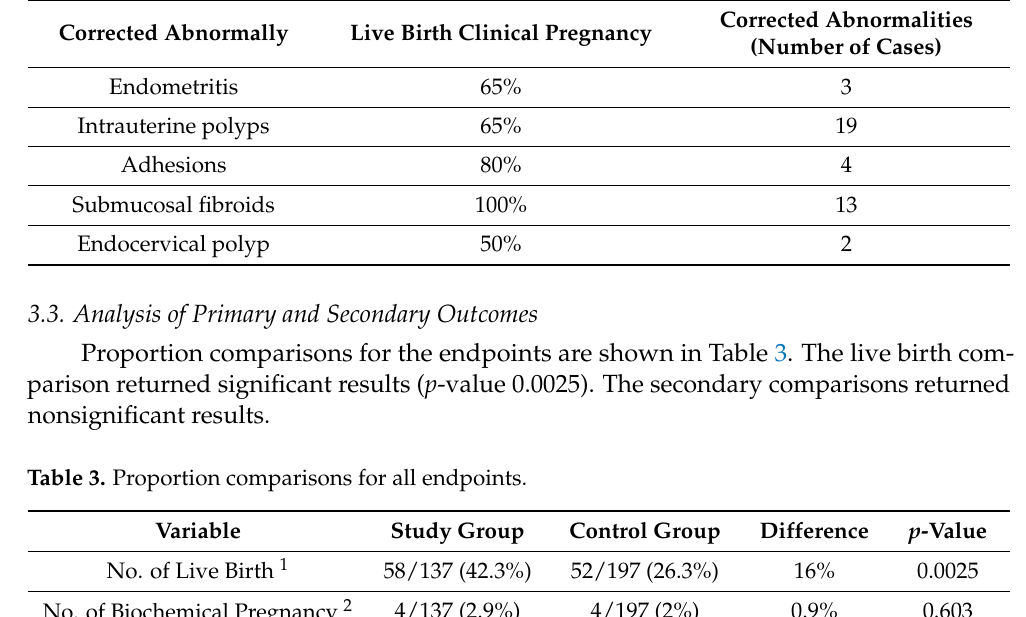
Corrected Abnormalities (Number of Cases)